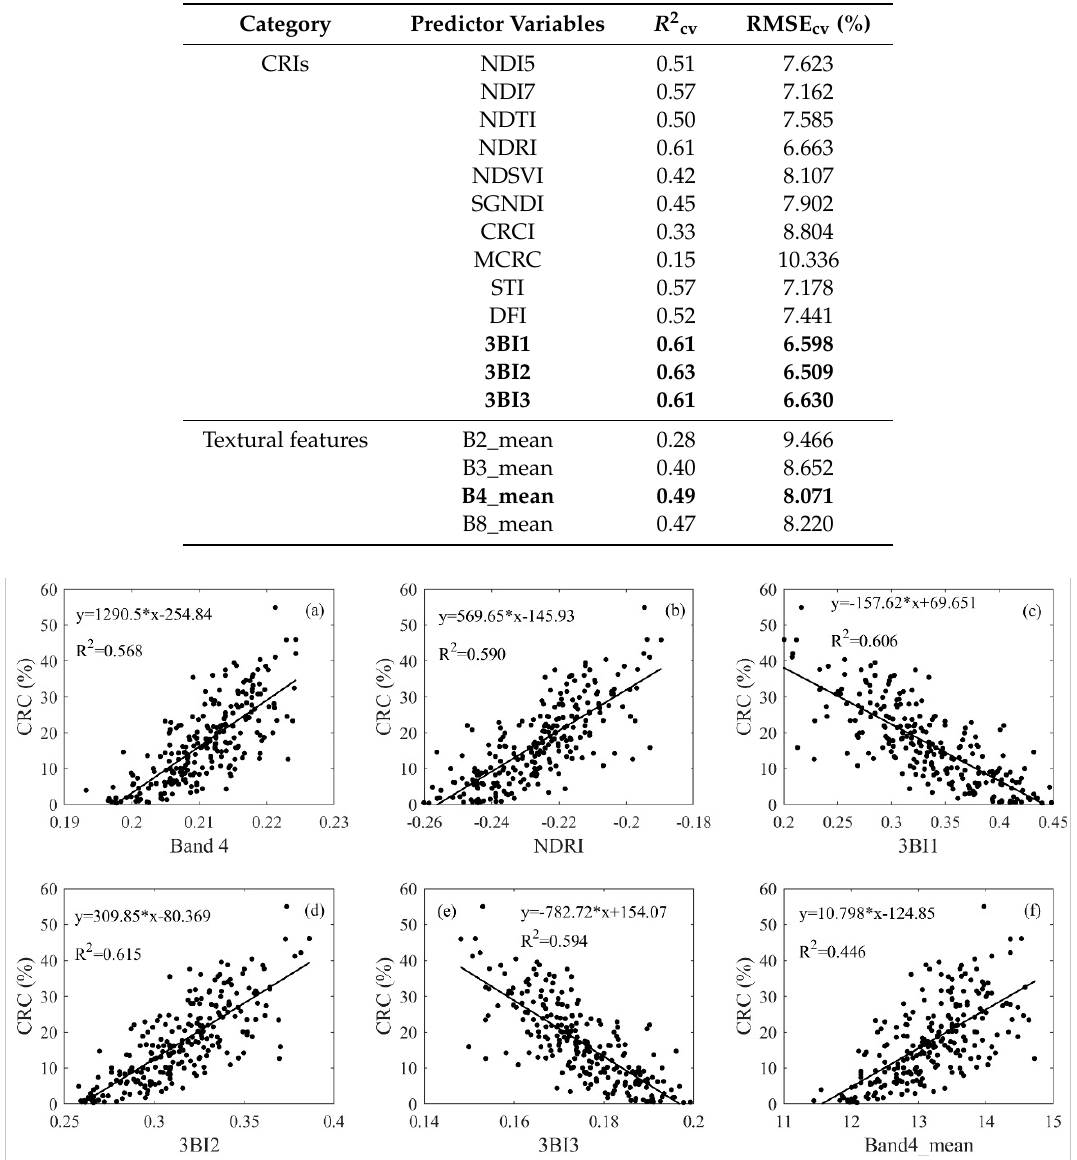
Figure 5. Regression relationships between CRC and the best predictors in each category (( a ): Band 4, ( b ): NDRI, ( c ): 3BI1, ( d ): 3BI2, ( e ): 3BI3, ( f ): Band4_mean) (Table 3).